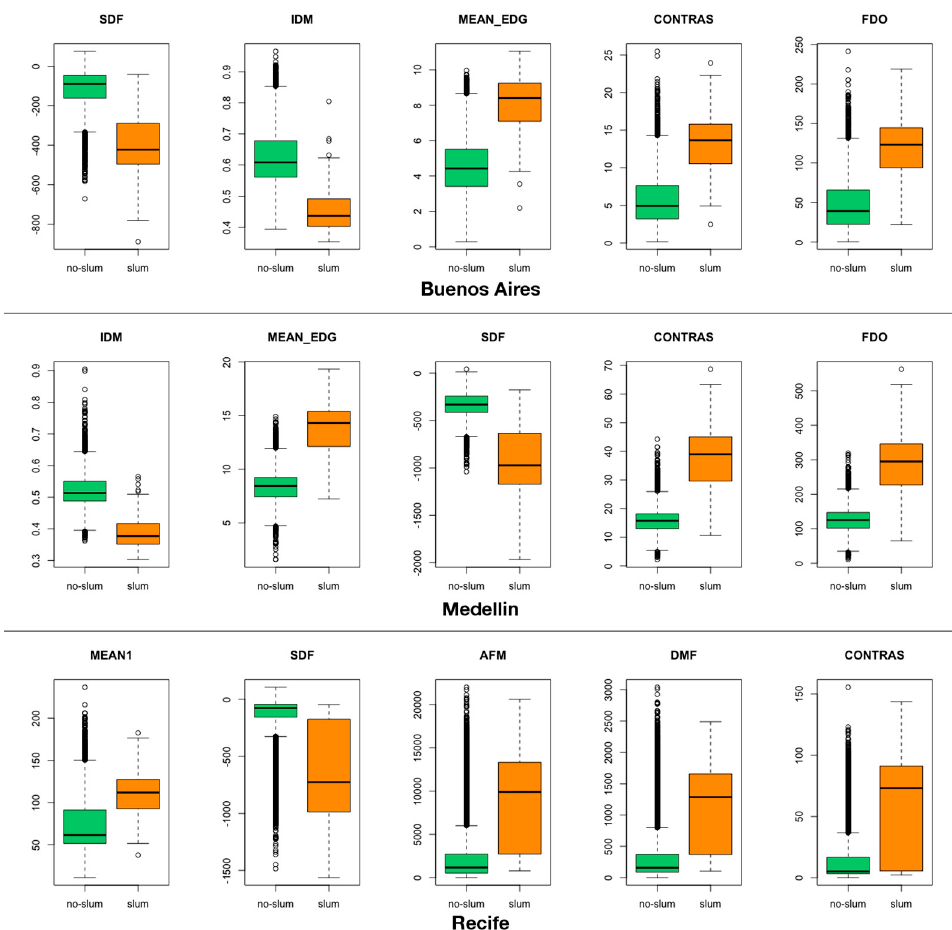
Figure 6. Boxplots of the distributions of the five most discriminant image-derived variables for each city. No-slum distributions are yellow and slum distributions are red. Variables are organized from left to right; the higher values of the Kolmogorov–Smirnov test are on the left and lower values are on the right.